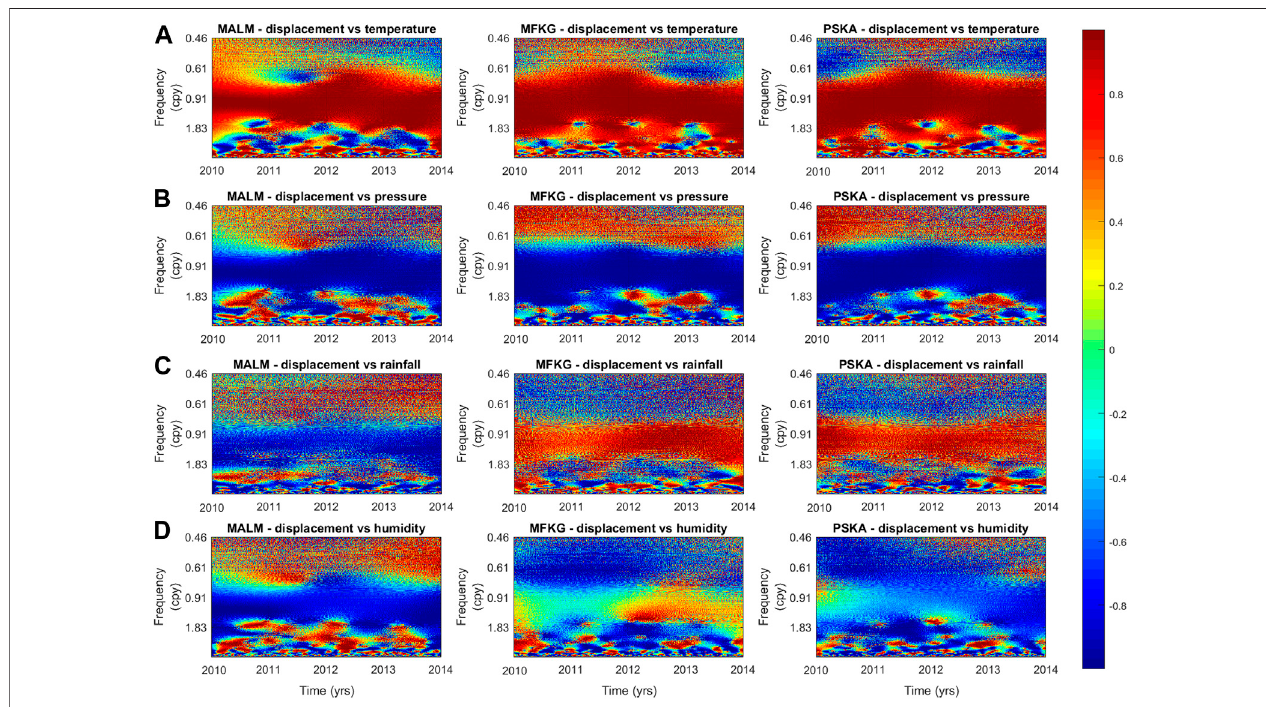
FIGURE 9 | cGPS surface displacement and meteorological time series wavelet-based semblance correlation spectra. (A) cGPS surface displacement- temperature spectra, (B) cGPS surface displacement-atmospheric spectra, (C) cGPS surface displacement-rainfall spectra, (D) cGPS surface displacement-humidity spectra.